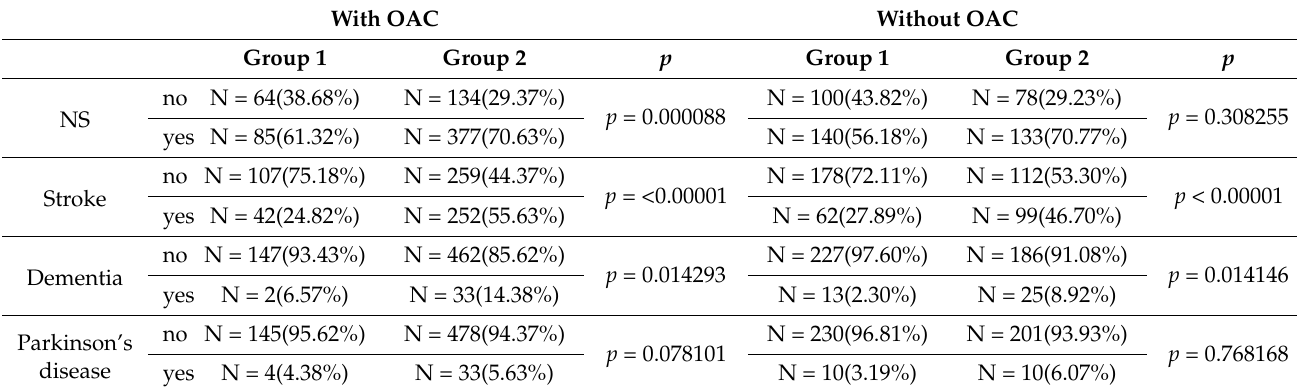
Table 9. Comparing patients with paroxysmal AF and permanent AF in the prevention of overall neuropsychiatric complications, stroke, dementia, and Parkinson’s disease undergoing treatment with and without oral anticoagulants, (using the Chi-square test).